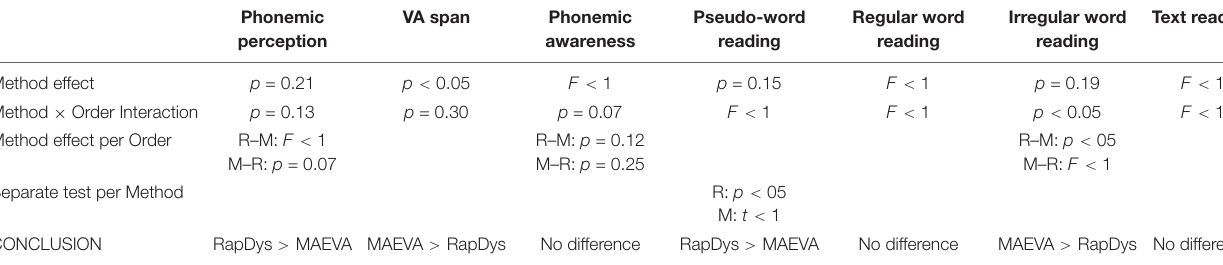
TABLE 2 | Summary of the statistical tests (R = RapDys; M = MAEVA).